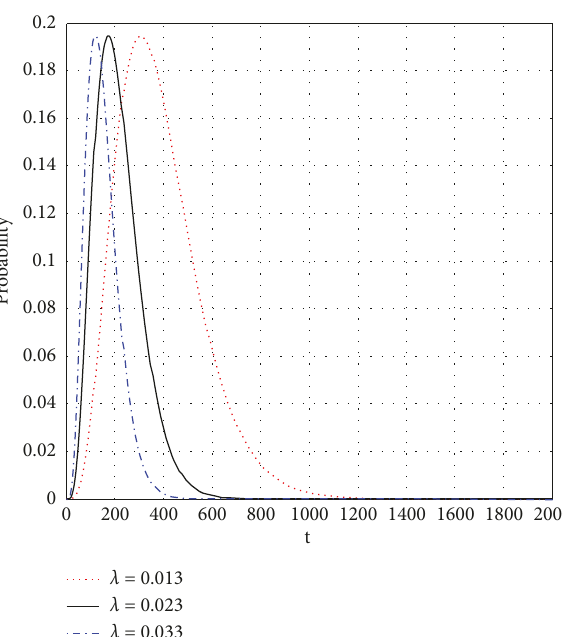
Figure 13: Sensitivity analysis of (P)